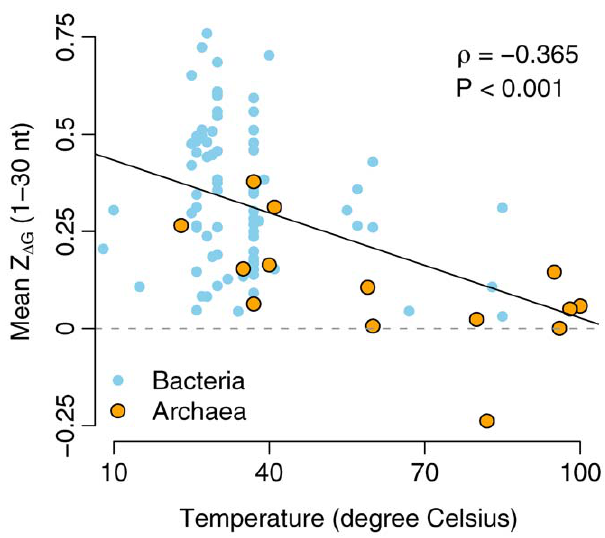
Figure 4. The mean Z D G of the first window as a function of the optimal growth temperature in prokaryotes. Each data point represents one organism.